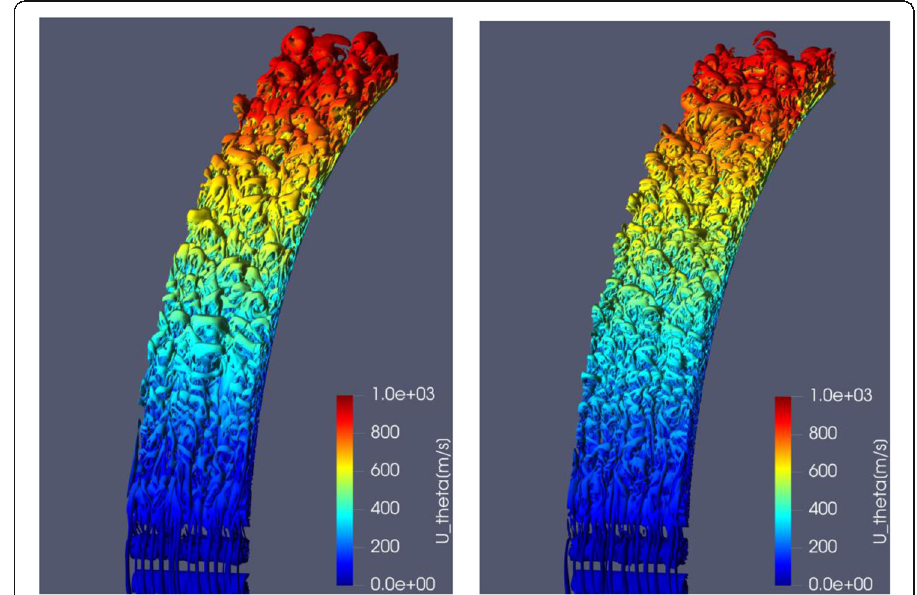
Fig. 13 Isosurface of Q-criterion. Left: (S1, Fine), Right: (S2,